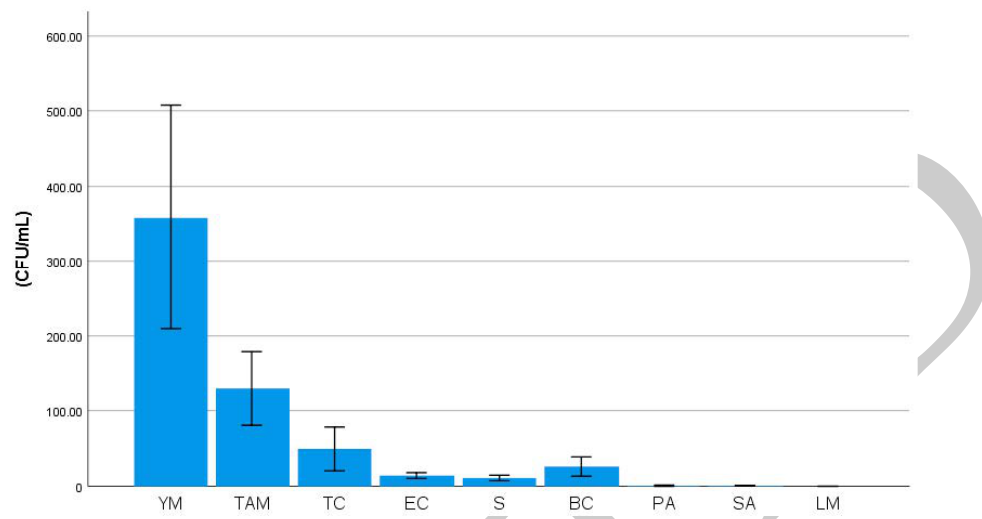
Figure 4. Median counts of indicator bacteria in the studied sample: YM: yeasts/molds, TAM: total aerobic mesophiles, TC: total coliforms, EC: Escherichia coli , S: Streptococci , BC: Bacillus cereus , PA: Pseudomonas aeruginosa , SA: Staphylococci aureus , LM: Listeria monocytogenes . There were statistically significant differences between the studied samples in the distribution of indicator bacteria. Fresh burgers had more total aerobic mesophiles, total co- liforms, Escherichia coli , and Bacillus cereus (Table 3). Table 3. Comparison between the different types of the sample regarding counts of Indicator bacteria. Counts of Indicator Bacteria (CFU/mL) Frozen Burger Fresh Burger Fast-Food